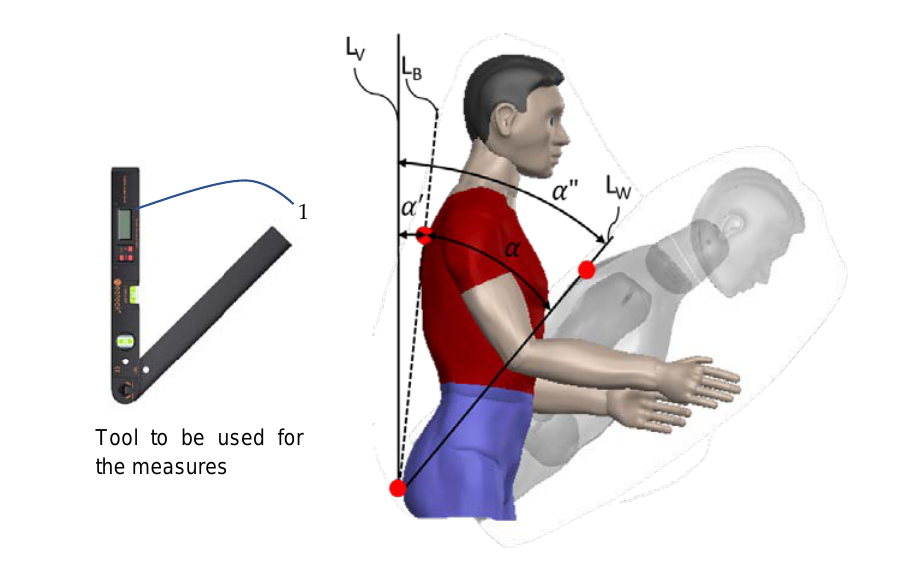
Figure 4. Practical procedure to measure trunk flexion.